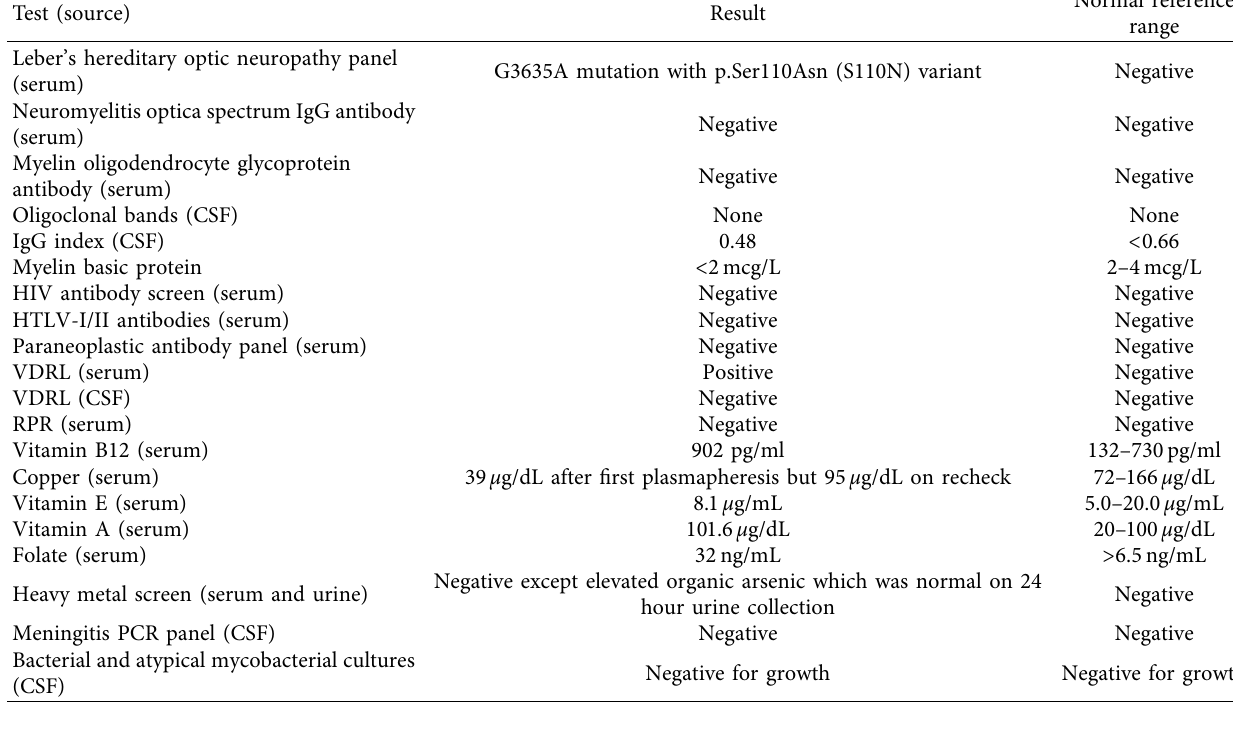
Table 1: Relevant cerebrospinal fluid (CSF) and serologic studies sent at initial presentation.